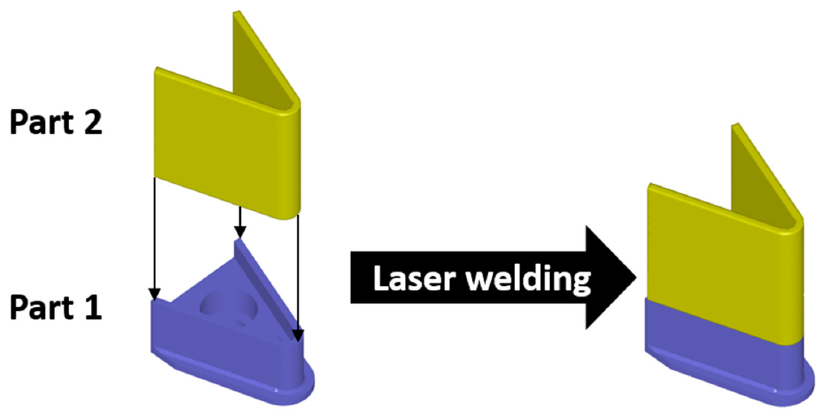
Figure 4. Assembly process for Part 1 and Part